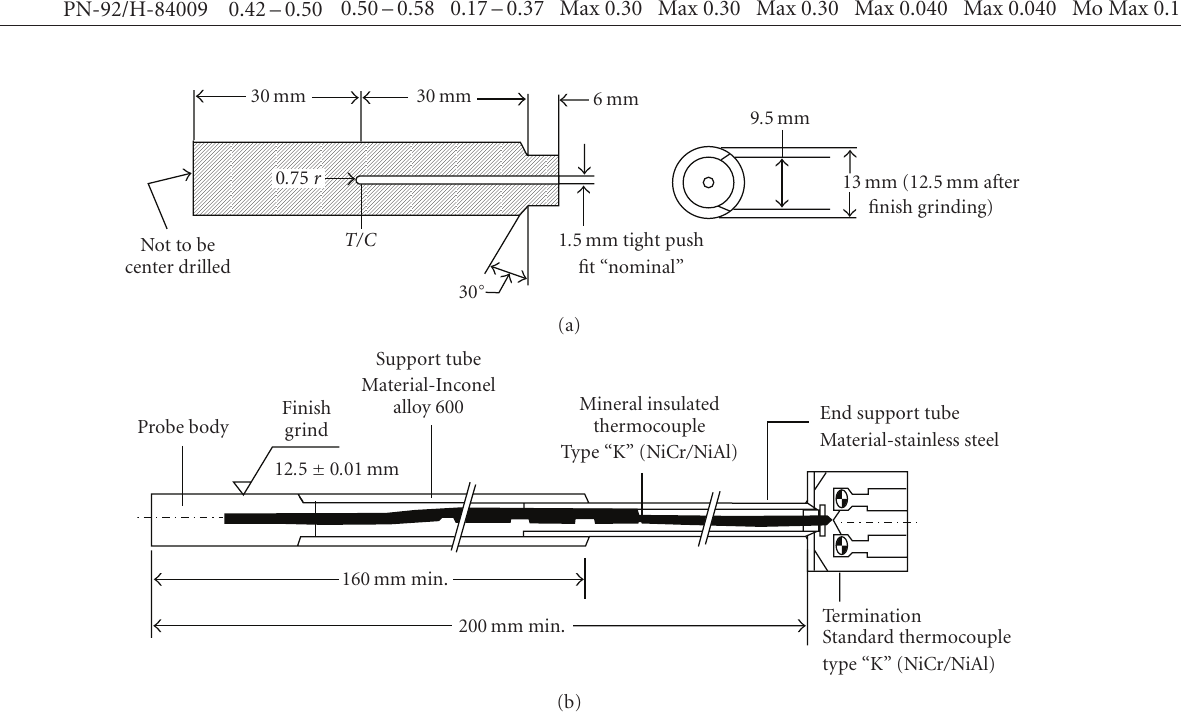
Figure 1: Schematic illustration of the so-called Wolfson probe used in ASTM D6482: (a) probe details, (b) general